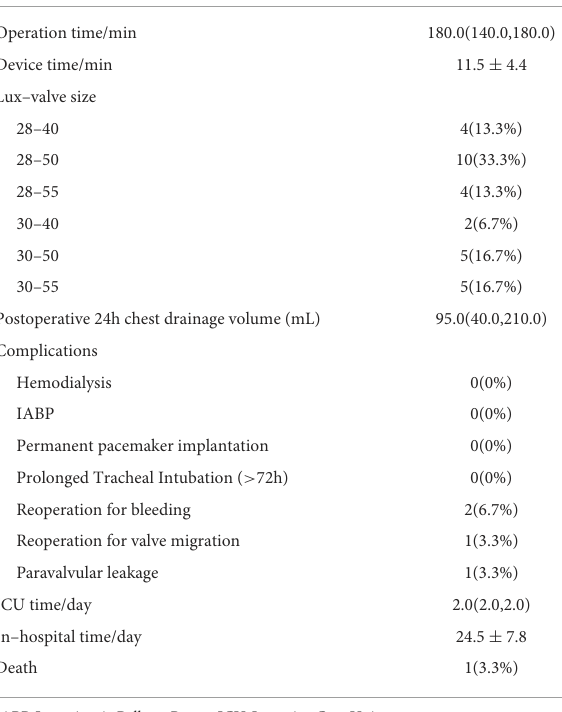
TABLE 5 Catheterization